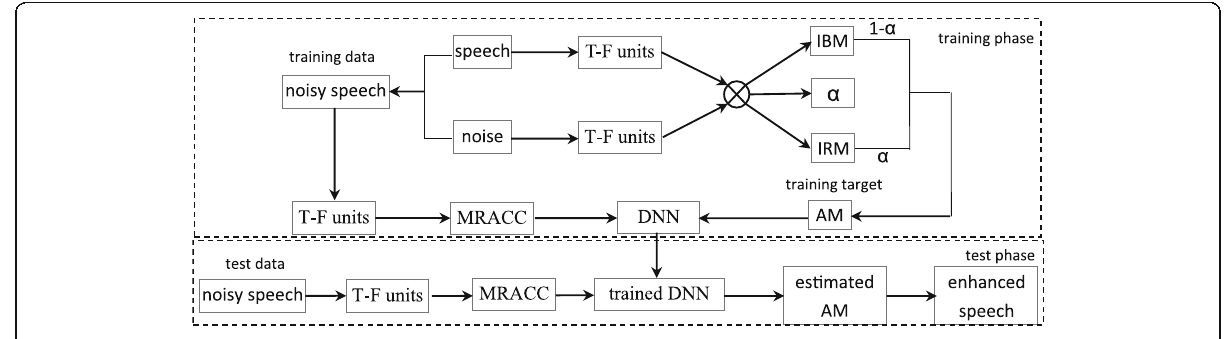
Fig. 6 The principle block diagram of speech enhancement algorithm